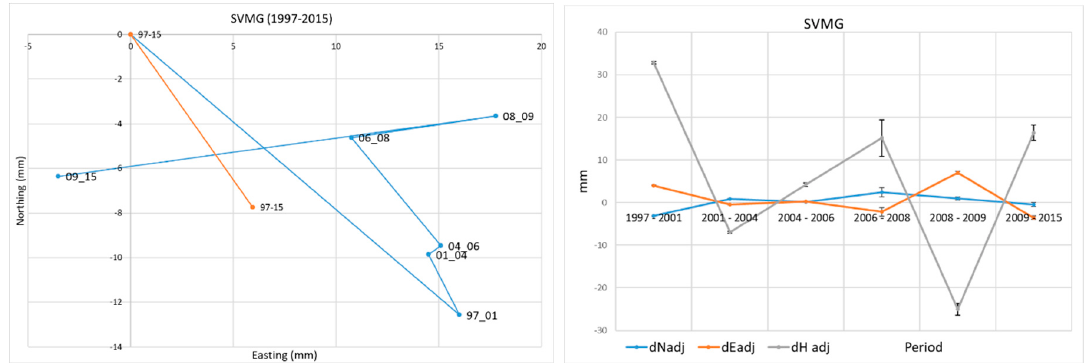
Figure 12. Point SVMG. Example of larger activities. Most active 1997–2001 and 2009–2015. Direction change due to compression of space.